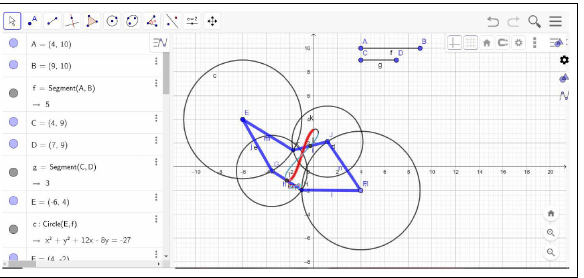
Figure 3. A reply, using GeoGebra, to the following task: In blue, Watt’s mechanism. G is the midpoint of BD. What is the locus of the midpoint of CE, compared to that of